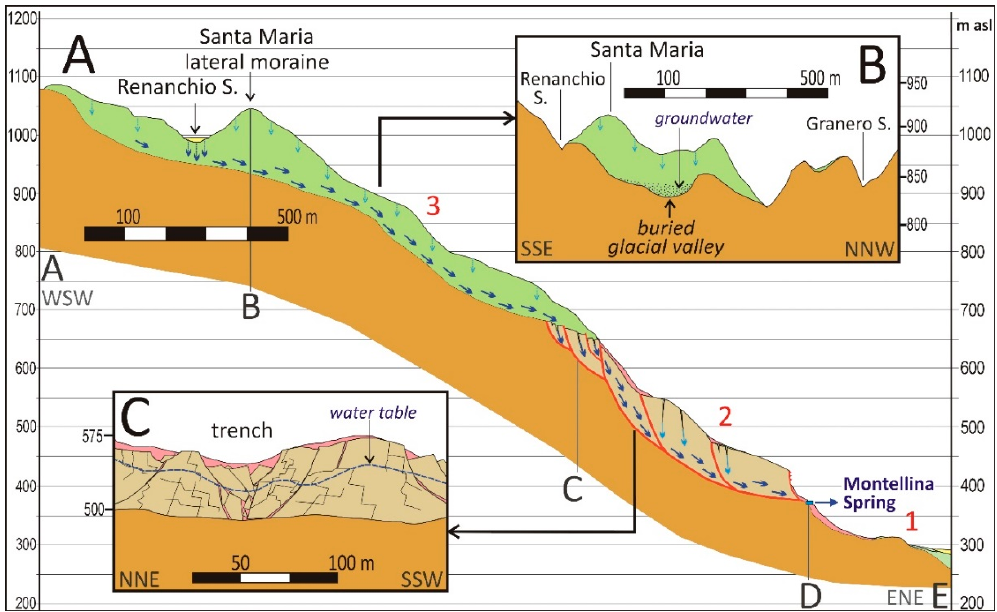
Figure 5. Schematic cross-sections (see the legend in Figure 4). (A) The water of the high Renanchio Stream (upstream of the fluorescein injection) infiltrates the glacial marginal sediments of sector 3 (upstream of the Santa Maria lateral moraine) and essentially flows through the buried glacial valley. This water flow continues in the loosened rocks of sector 2, supplied by the water infiltrating in the open fractures, feeding MS. (B) Cross-section of the buried glacial valley, covered by glacial deposits, in which groundwater is conveyed. (C) Detail of the loosened rocks that transfer the groundwater of the buried glacial valley to MS, especially through longitudinal trenches.